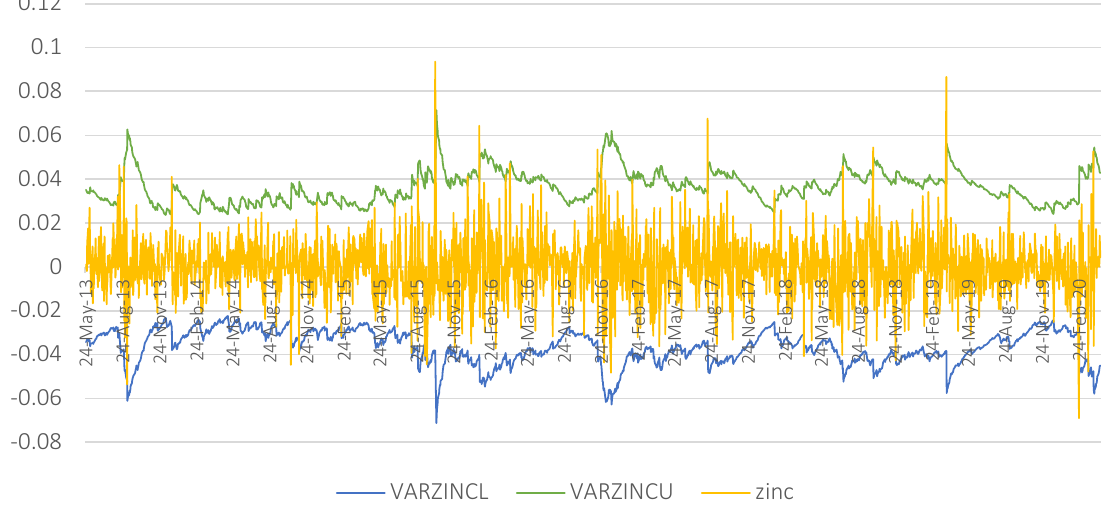
Figure 3. Rolling VaR values and returns of zinc futures